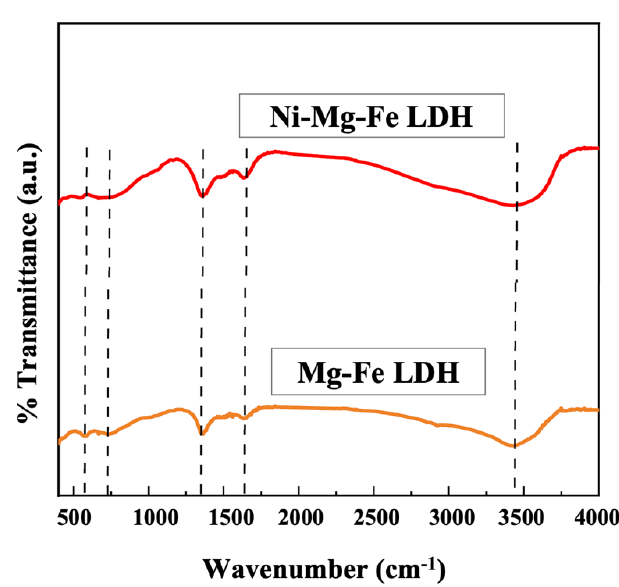
Figure 4. FTIR spectra of the Mg-Fe LDH and Ni-Mg-Fe LDH catalysts.